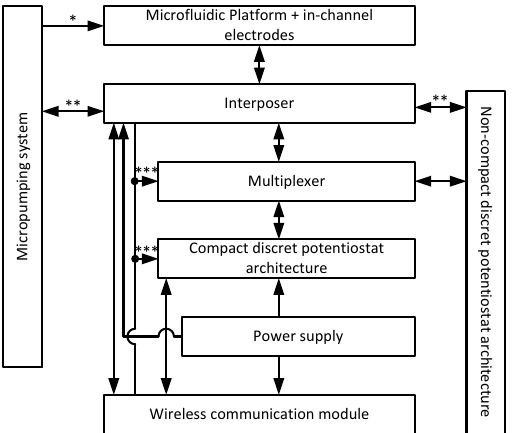
Figure 1. (a) LoC modular and plug-and-play schematic of functional each module (microfluidic/sensor, microcontroller and fluid handling). The Figure 3. Schematic illustration of the proposed LoC architecture including the connection of the microcontroller part consists of Arduino nano implemented with the interposer with other electronics modules. * refers to the tubing between the microfluidic platform and potentiostats circuits and the micropumping module. Interface with computer is wireless or USB. (b) Self-contained LoC with outer dimensions 5 the micropumping system. ** refers to optional connections; these optional connections are related to cm x 4 cm x 4 cm (defined by blue box). LoC plug-and-play internal power supply and wireless communication. *** refers to optional power supply distribution through architecture showing microfluidic chamber, potentiostat and other electronic the interposer circuitry. (c) Bluetooth wireless communication and (d) interposers for connection between different modules.